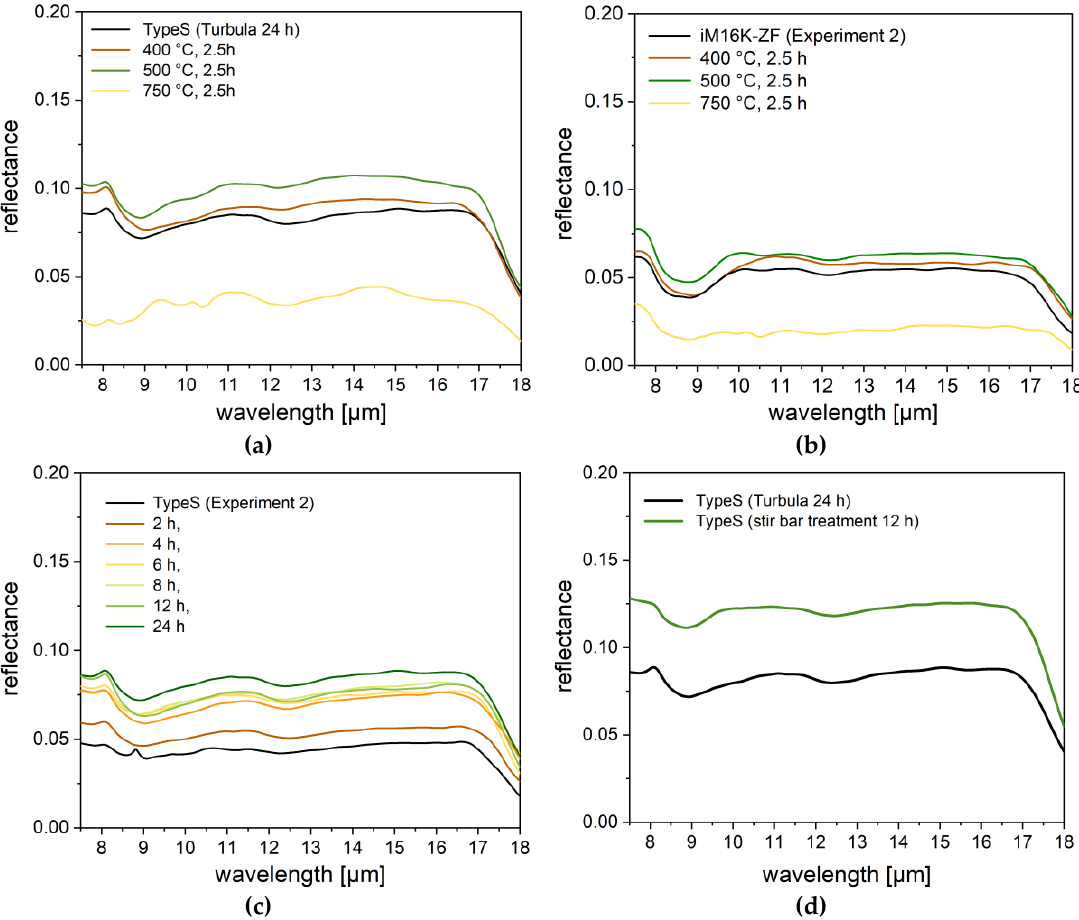
Figure 17 . Measured reflectance of the post treated MGS from Experiment 2 A and 2 B, ( a,b ): Furnace treatment; ( c ): Turbula® Mixer, and ( d ): Stir bar treatment, an increase in reflection can be determined for all three post-treatments.